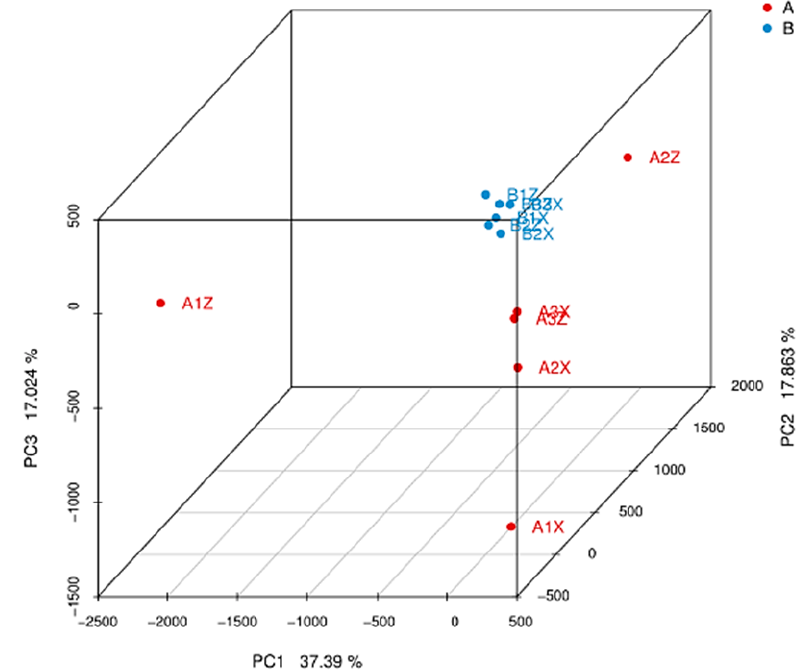
Figure A1. Principal component analysis of bacterial communities in two types of litter from plantation forest (A) and original forest (B).